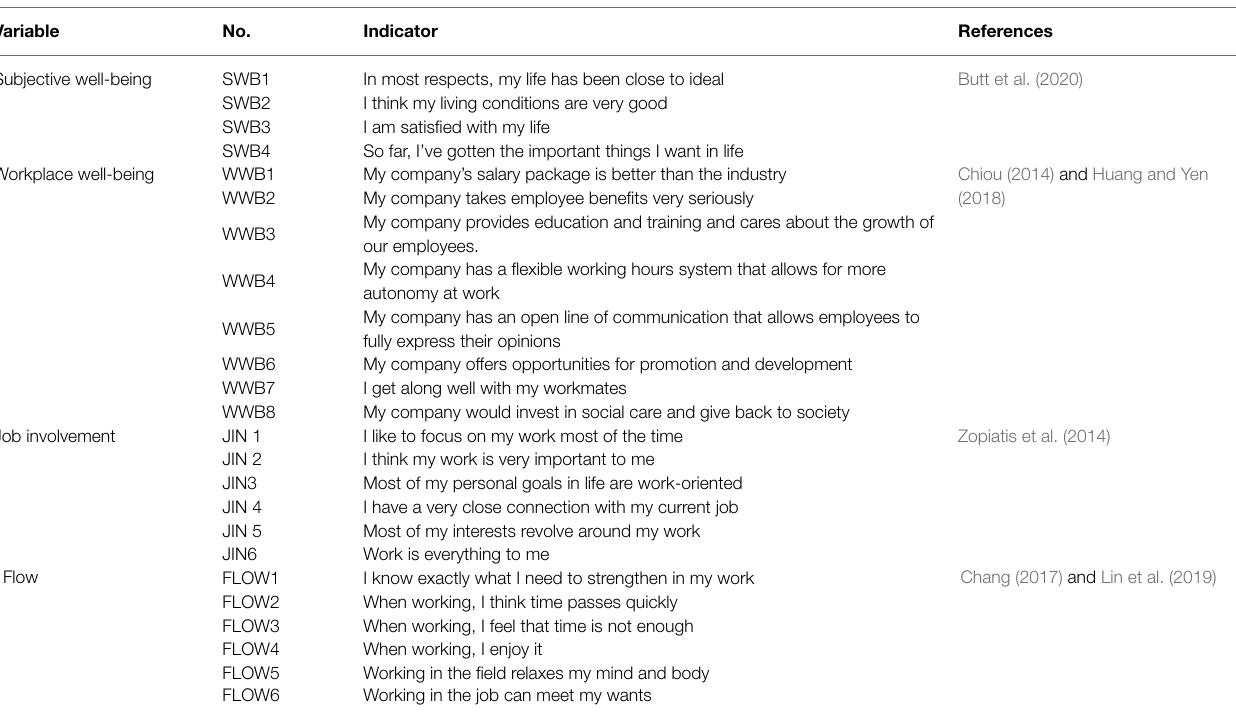
TABLE 2 | Summary of measurement indicators.